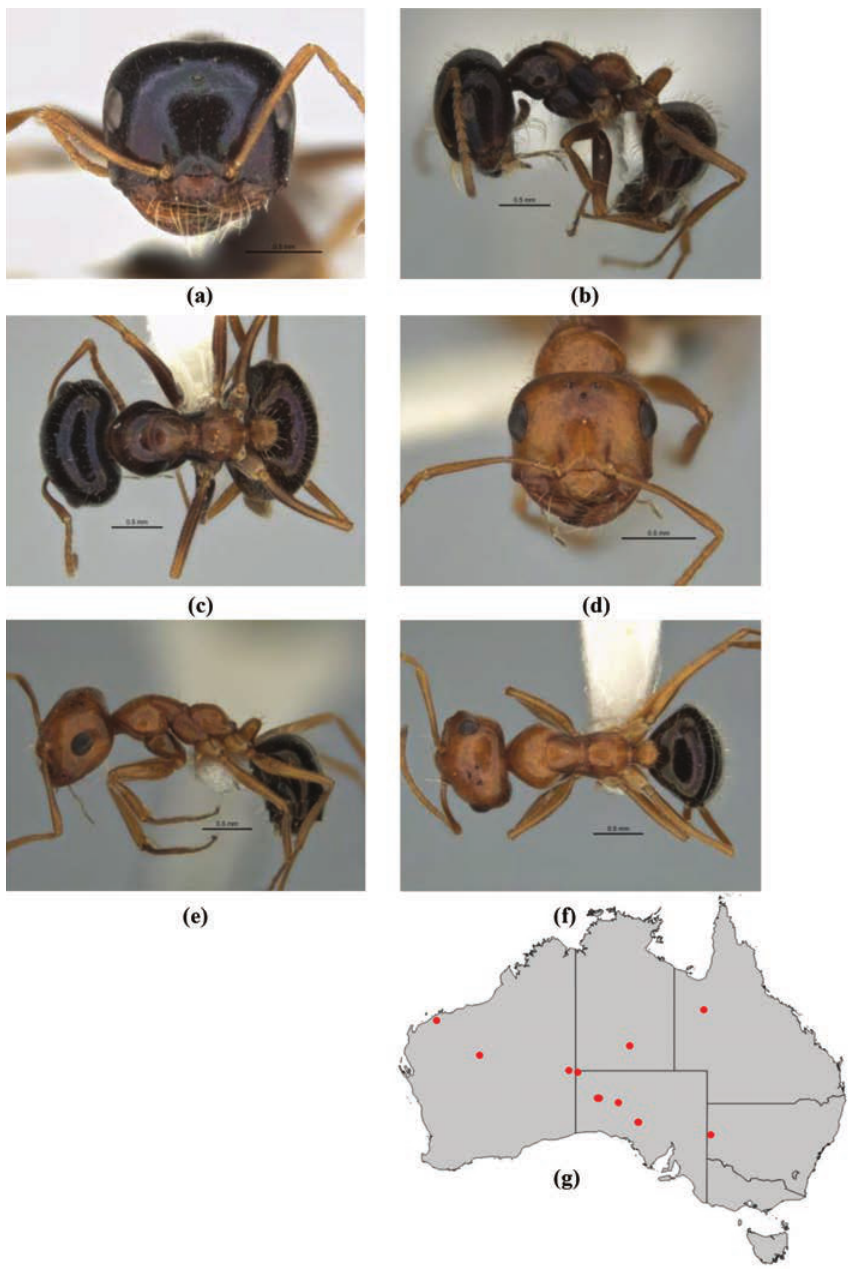
Figure 77. Melophorus caeruleoviolaceus sp. n.: major worker paratype (ANIC32-900182–bottom ant) frons ( a ), profile ( b ) and dorsum ( c ); minor worker holotype (ANIC32-900183–middle ant) frons ( d ), profile ( e ) and dorsum ( f ); distribution map for the species ( g ). Low resolution scale bars: 0.5 mm ( a–f